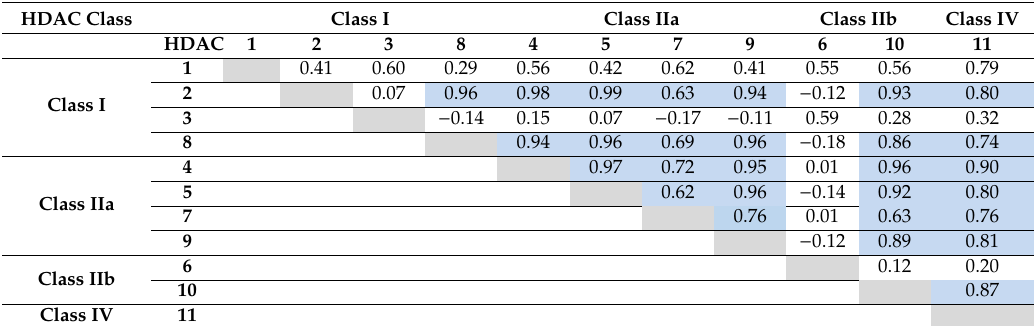
Table 2. Correlation of the expression levels of di ff erent HDACs in human HCC tissues (n = 11). HDAC Class